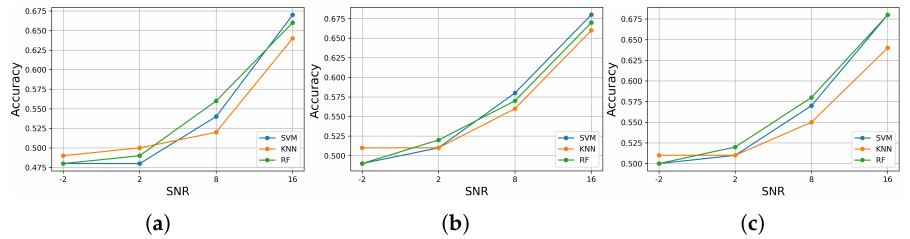
Figure 12. The accuracy performance of predicting the classes of the signal with added noises by the trained models, ( a ) for added muscle artifact noise, ( b ) for added electrode motion noise, ( c ) for added baseline wander